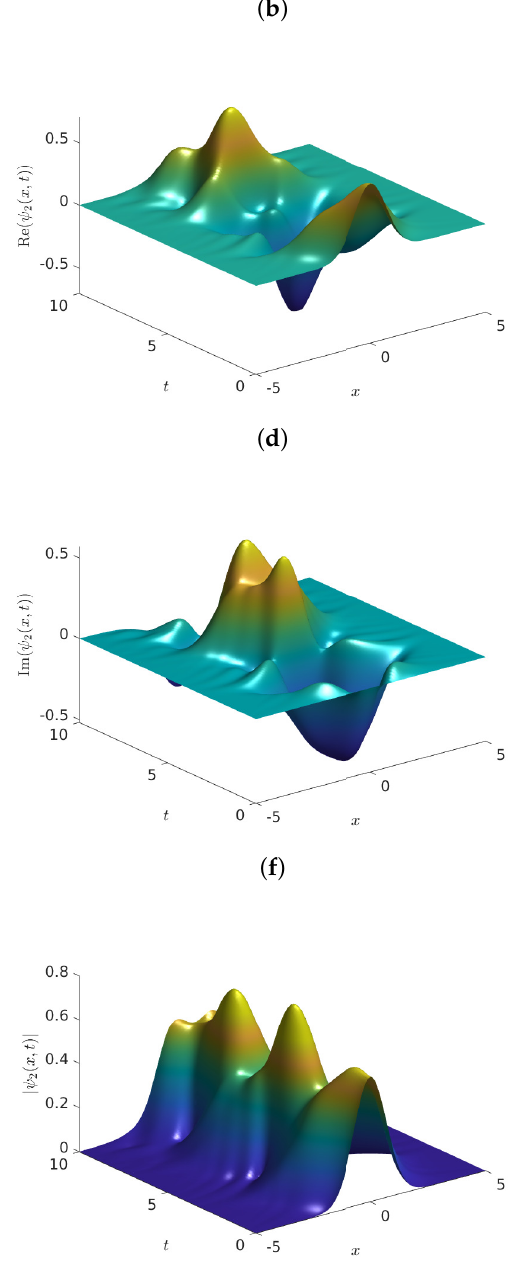
Figure 3. Approximate solutions for the problem (4) using the parameters in Table 1, and the computational time-steps h = 0.1 and τ = 0.05 for the finite-difference method (36). We used V ( x ) = 1 1 √ exp ( − x 2 ) . The graphs provide the behavior of ( a ) Re ψ 1 , ( b ) Re ψ 2 , ( c ) Im ψ 1 , ( d ) Im ψ 2 , ( e ) | ψ 1 | , and ( f ) | ψ 2 | , versus π ( x , t ) . In these simulations, we used α = α = 2 1